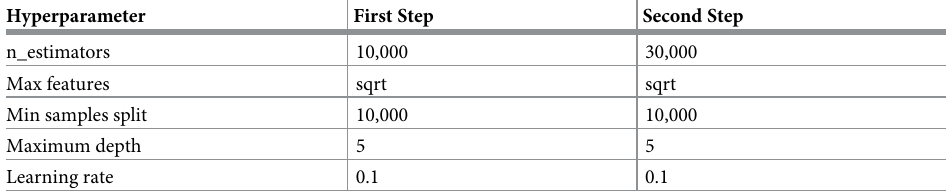
Table 4. Hyperparameters used by the GBR